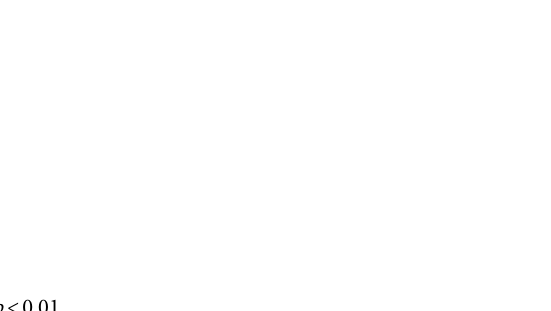
Table 5. Intrarater and interrater reliabilities. * p <